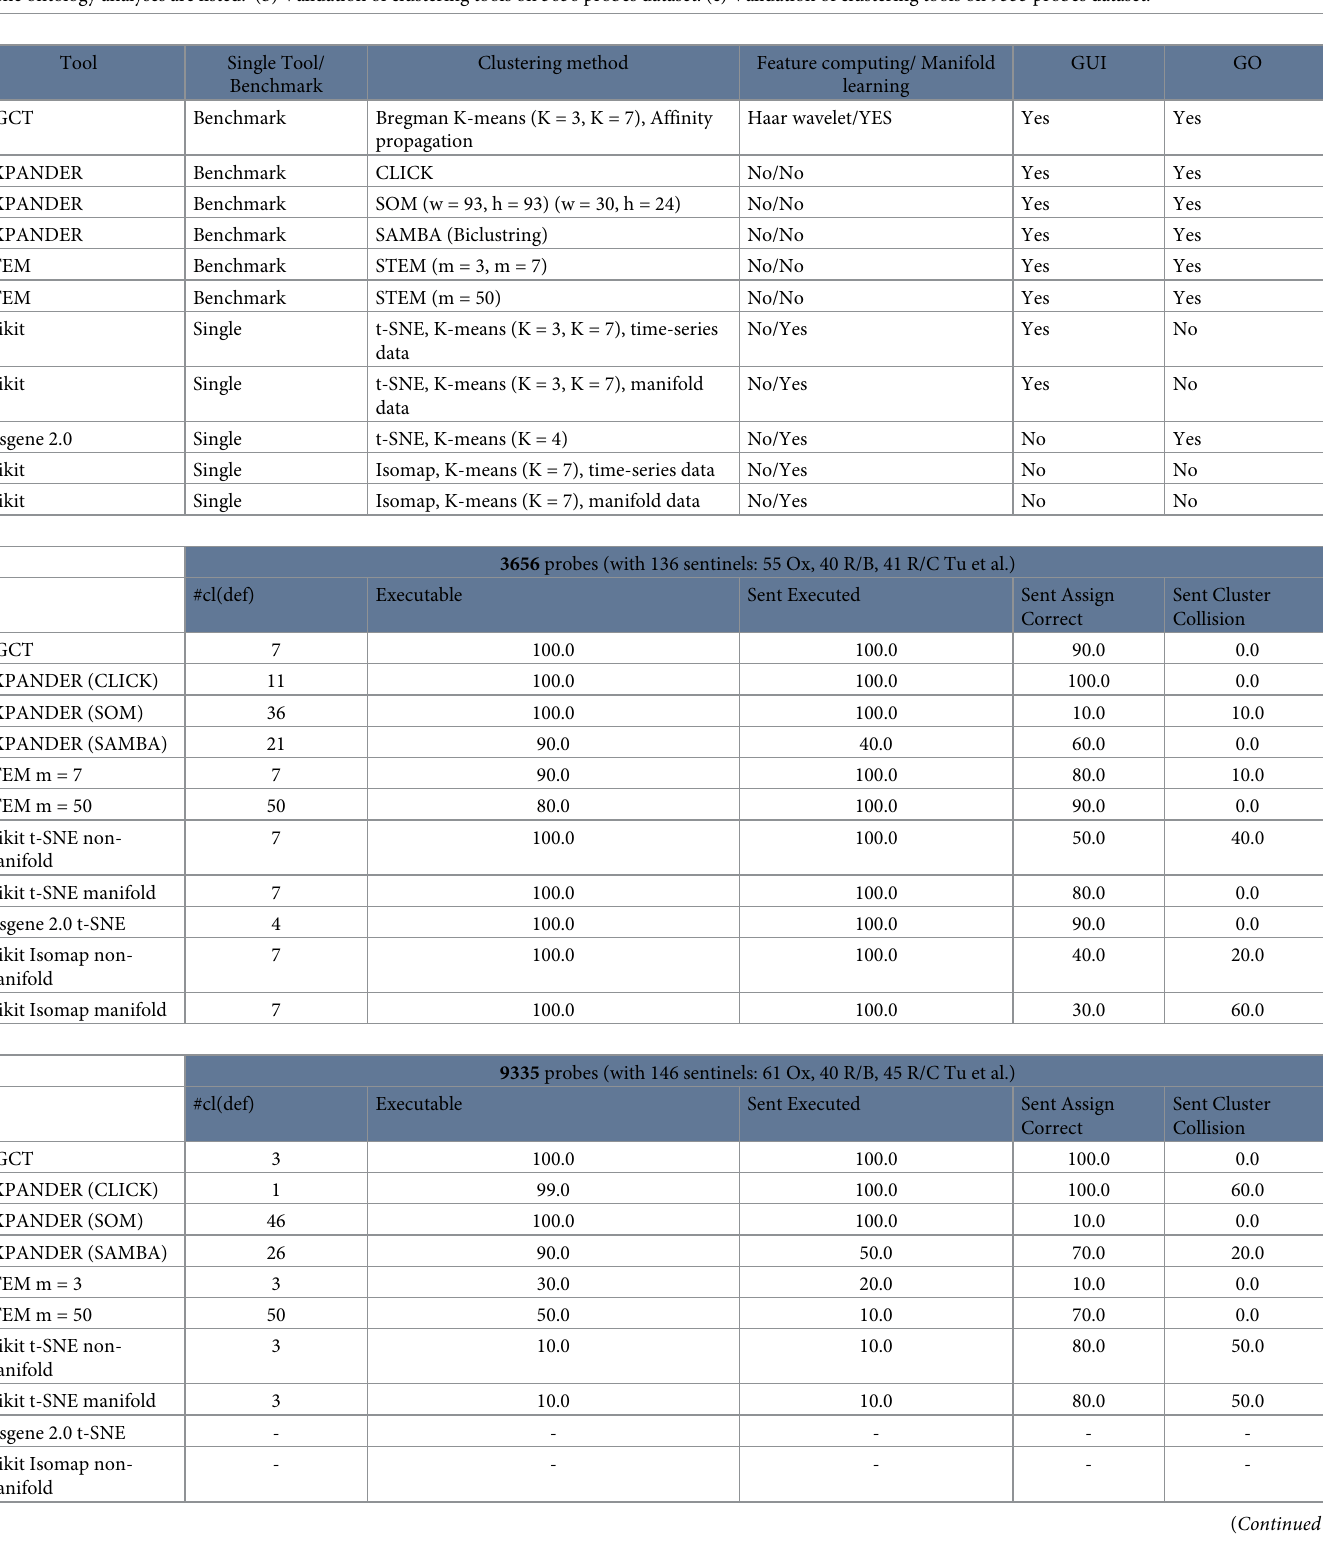
Table 2. (a). Characteristics of tools similar in features with AGCT and selected for testing. Methodoly, features, and presense/absence of graphical user interface and Gene ontology analyses are listed. (b) Validation of clustering tools on 3656 probes dataset. (c) Validation of clustering tools on 9335 probes